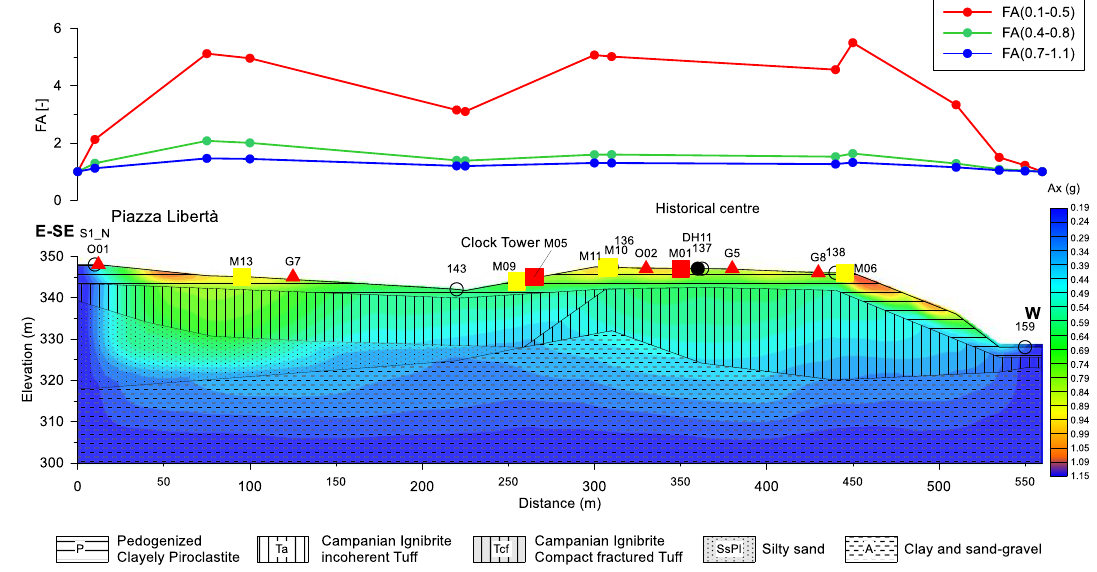
Figure 9. Top : 2D amplification factors obtained with Equation (1) in three different period ranges. Bottom : contour map of the maximum acceleration (peak ground acceleration—PGA) over imposed to the geological section.